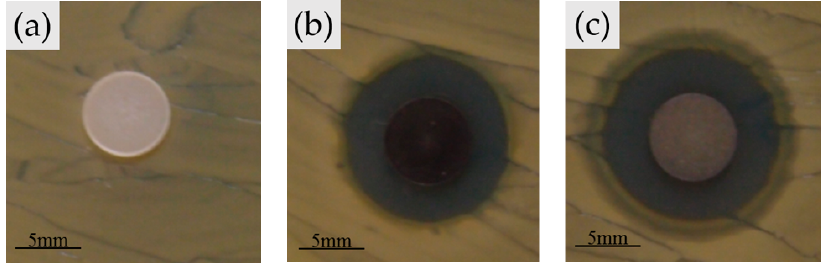
Figure 7. Disc di ff usion method of ( a ) 80S; ( b ) Ag1 / 80S; and ( c ) Ag10 / 80S powder disc against Figure 7. Disc diffusion method of ( a ) 80S; ( b ) Ag1/80S; and ( c ) Ag10/80S powder disc against Staphylococcus aureus ( S. aureus , ATCC 6538). Staphylococcus aureus ( S. aureus, ATCC 6538).